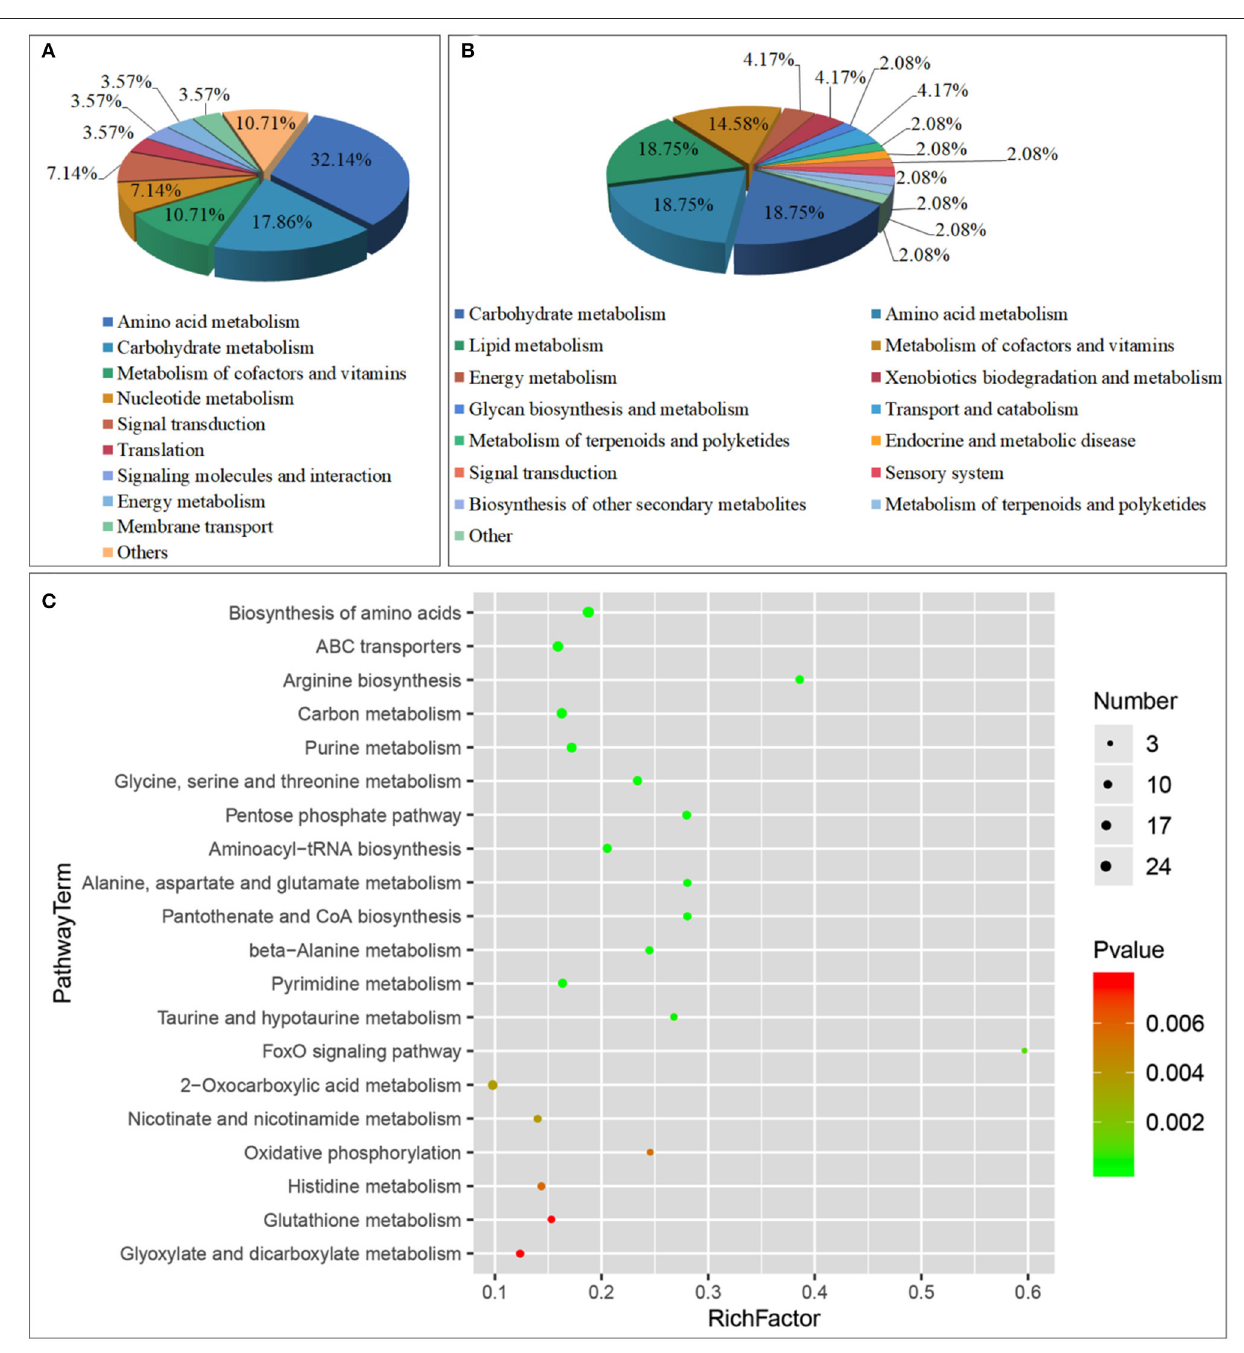
FIGURE 7 | Class of Metabolic pathway pie chart in the gill tissues of the S.paramamosain adapting to low salinity: significant enrichment (A) and non-significant enrichment (B) in correlation analysis; the metabolome view map of top 20 significant enrichment metabolic pathways in the gill tissues of the S.paramamosain adapting to low salinity (C) in correlation